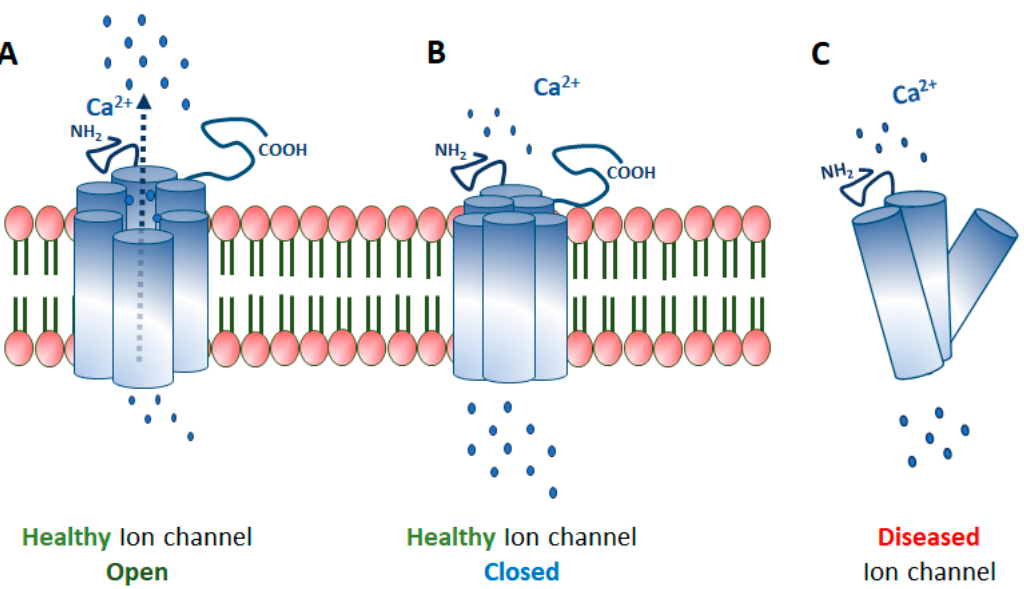
Figure 1. Ion channels; ( A ) An ion channel is open, allowing the flow of Ca 2+ ions, ( B ) A closed ion channel limiting the flow of ions, ( C ) A truncated (diseased) ion channel not trafficked to the membrane due to dismantled subunits.